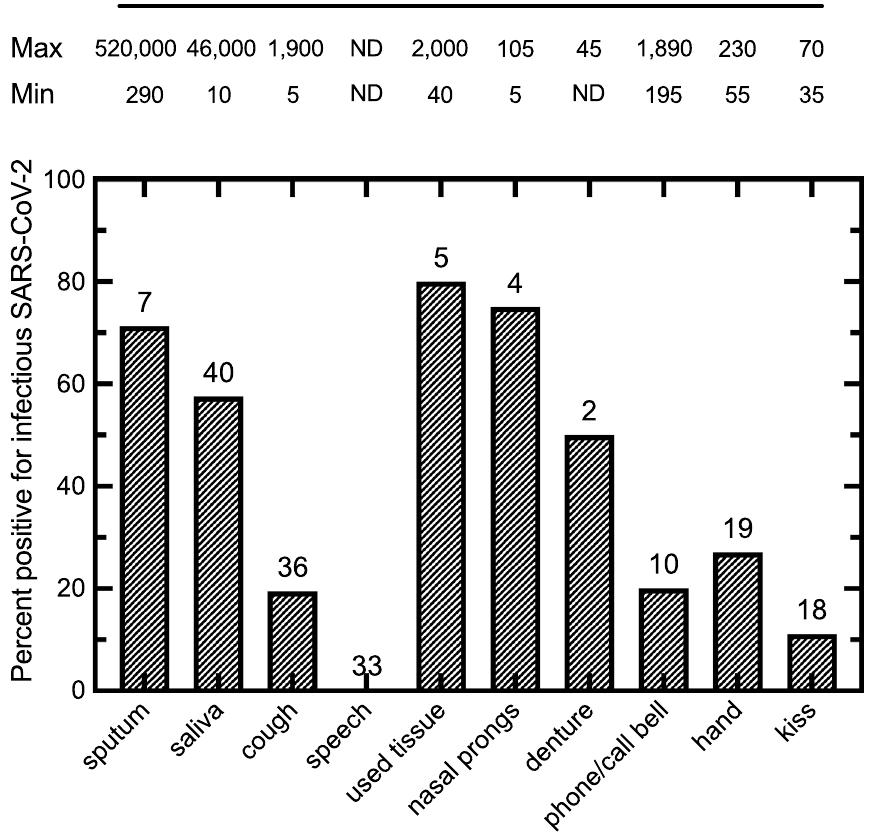
Figure 4. Percentage of clinical and environmental samples positive for infectious SARS-CoV-2 from patients with positive NP or TS by infectious titer. The number of samples acquired in each category are indicated above each bar, along with the minimum and maximum infectious titer (PFU/mL) observed for each sample along the top of the figure. Not all sample types were collected from every patient. Sputum indicates productive cough samples. ND = None detected. Figure prepared using Prism v9.3 (https:// www. graph pad.